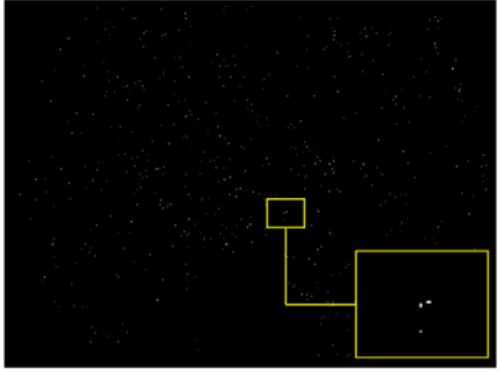
Figure 5. Example of 25 × 25 patch size of background